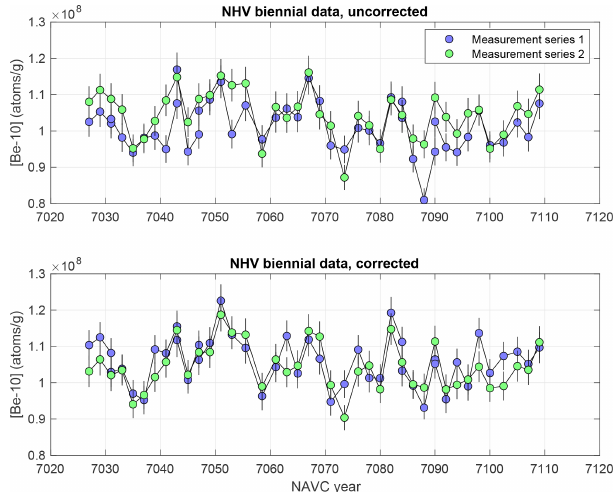
Figure 7. Effect of current dependence bias correction on agree- ment between replicate analyses of NHV biennial samples. All data are assigned 4% uncertainties as discussed below.